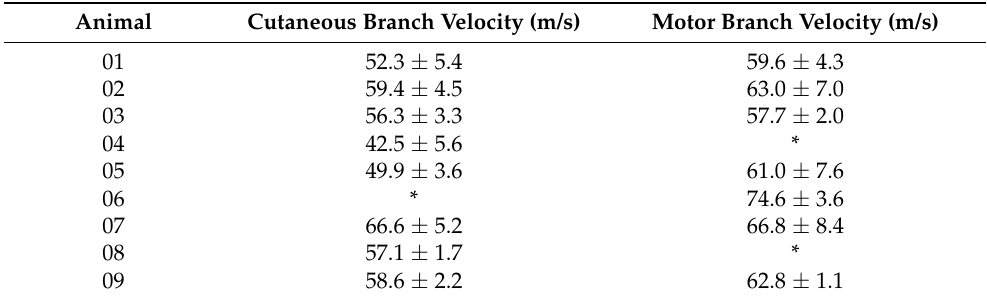
Table 1. Single animal velocity distribution (mean ± standard deviation)—the asterisk (*) denotes the animal and branch in which stimulation artefact contamination was observed. Animal